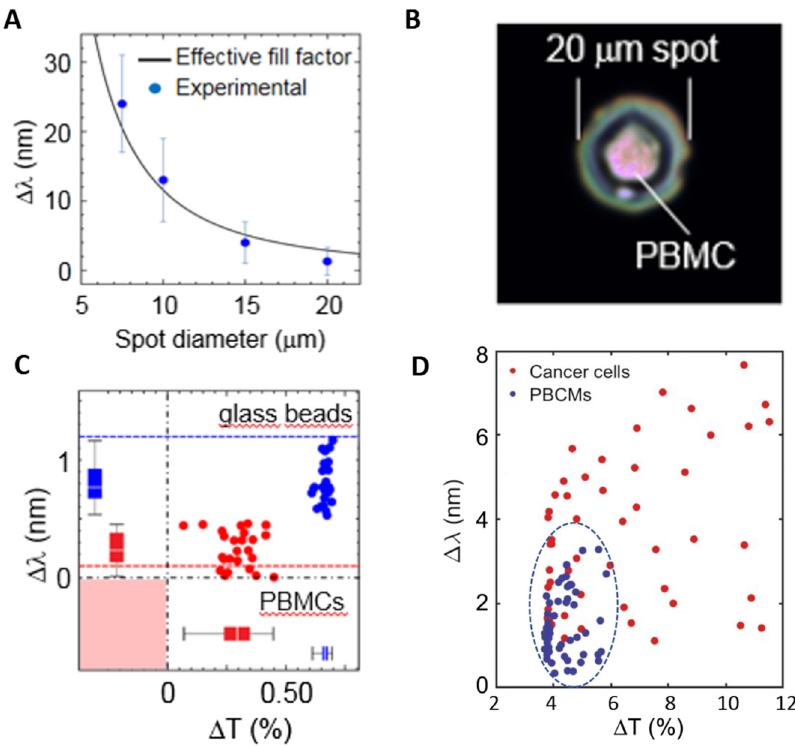
Figure3: Effectiverefractiveindexmodel:(A)Spectralshiftduetosingleglassmicrospheresasafunctionoftheilluminationspotsize,D.Dots are experimental data and solid line represents a theoretical fit to the model described in the text. (B) A single PBMC on the nanohole array illuminated with a spot size of 20 μ m. (C) Glass beads (10 μ m in diameter) and PBMCs (70 – 90% lymphocytes) were analyzed with an illuminationspotof20 μ mbydeterminingthespectralshiftandthechangeintransmittance.Dash-dottedlinesmarkthevaluesof0for Δ λ and Δ T . Blue dotted line marks the spectral shift of the glass microbeads obtained according to the effective refractive index model described in Sect. 2.2. Red dotted line marks the spectral shift for PBMCs according to Metcalf et al. [31]. Electromagnetic simulation of the system “ cell- nanostructured substrate ” : (D) Numerical simulation ( Δ λ vs Δ T ) of the electromagnetic problem of either PBMCs (blue dots) or SW480 cancer cells (red dots) located on a nanohole structured substrate (see details in the text and Figure